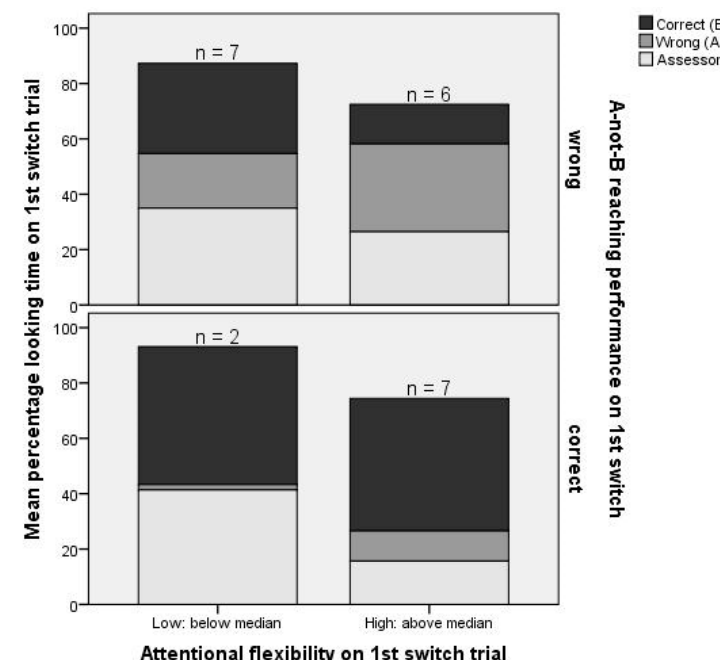
Figure 5. Reaching performance on the first switch trial in relation to looking behavior on that trial.